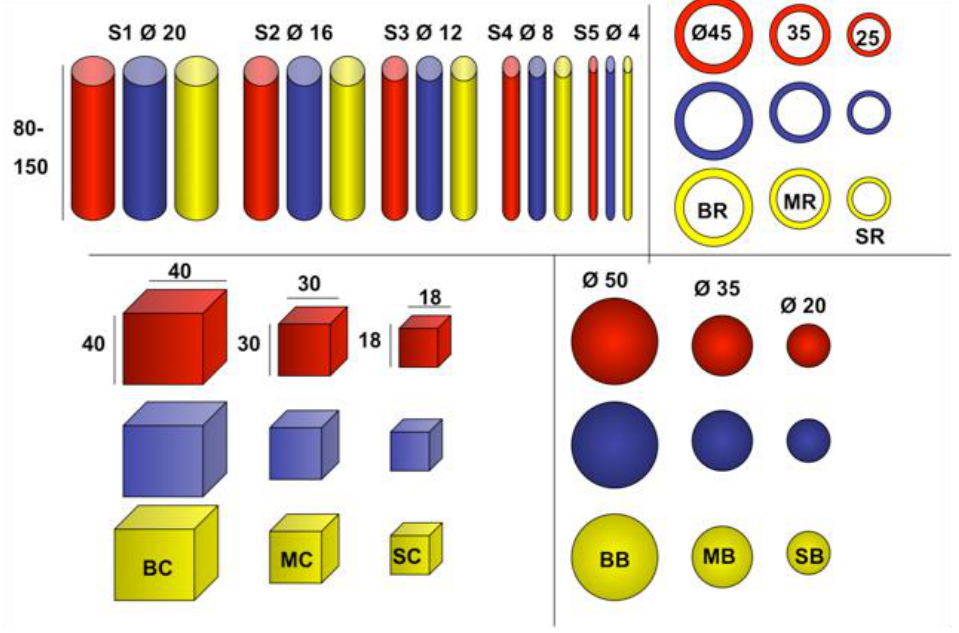
Figure 2. Wooden objects (dimensions in mm); Cubes: Big Cube (BC), Medium Cube (MC), Small Cube (SC); Balls (BB-SB); Rings (BR-SR). Sticks (S1-S5) were 80, 100 or 150 mm long (100 for Goffins, 150 for kea, BPC). Goffins and kea initially had a smaller sized ball (10 mm diameter), which was not licensed to be offered to zoo parrots. As in Auersperg et al. (in press), in agreement with the authors of the previous